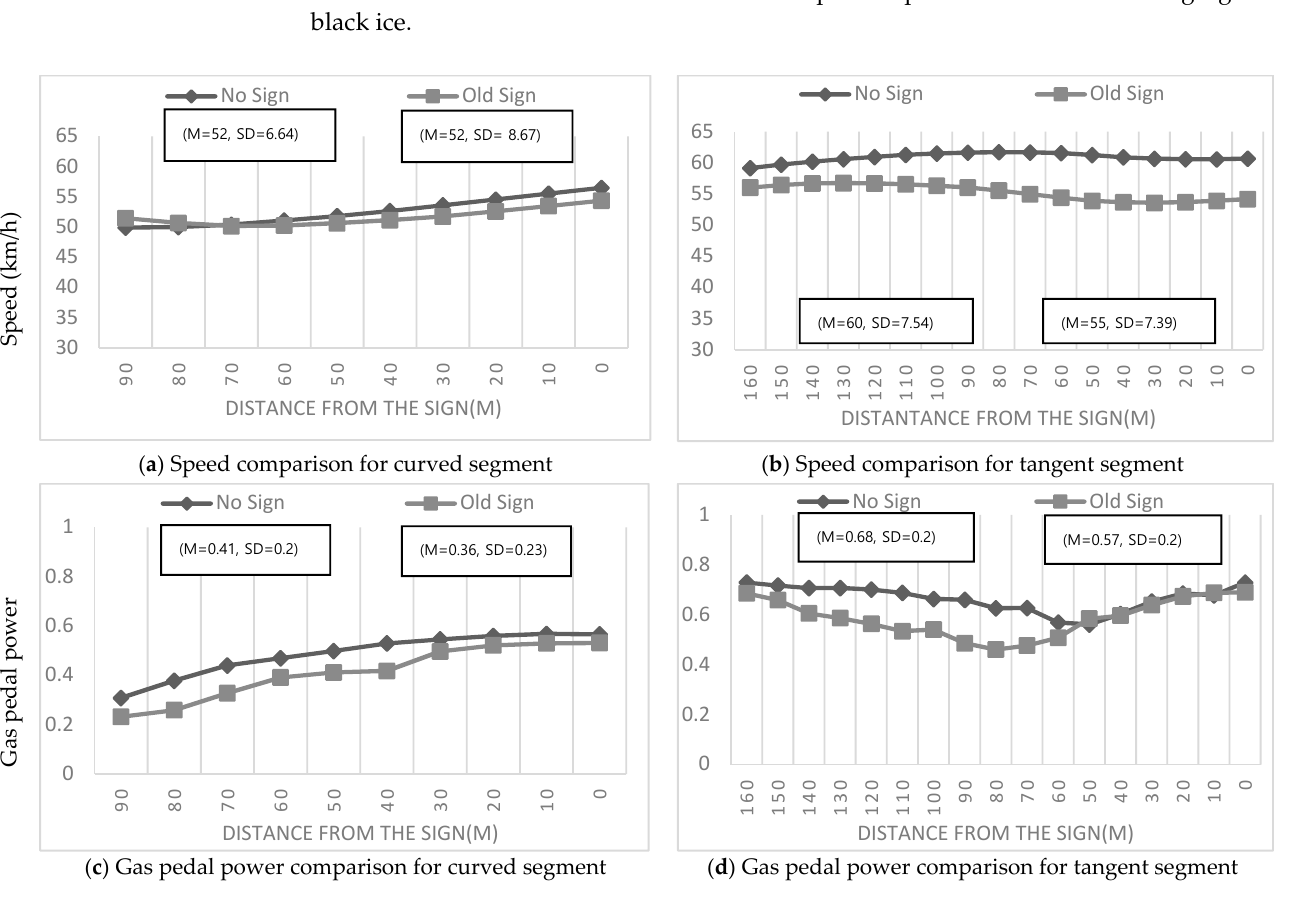
Figure 6. Comparison between no-sign conditions and conventional static warning signs for black ice.